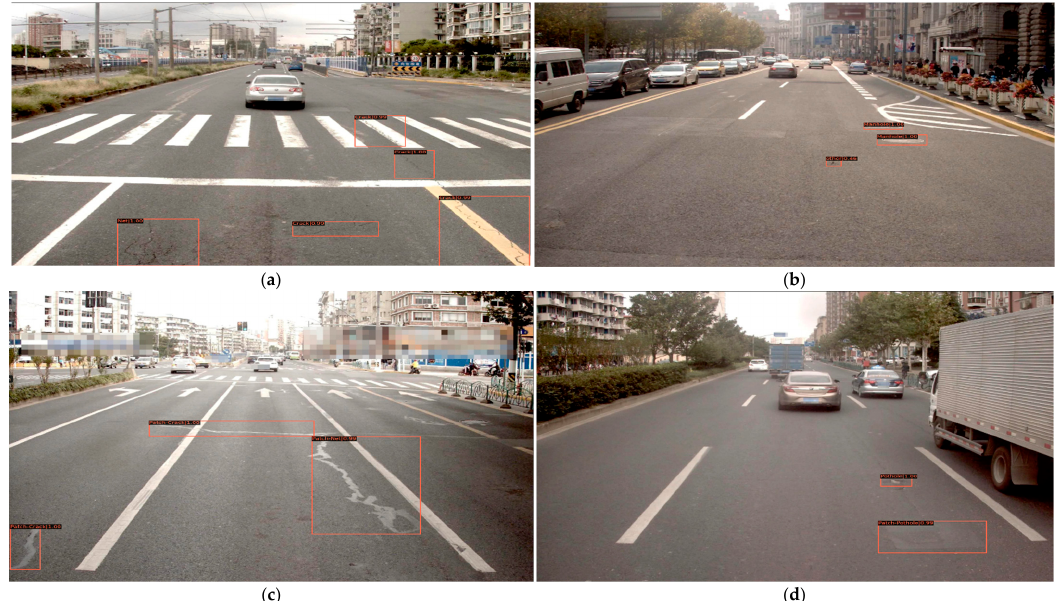
Figure 9. Disease detection samples for DASNet. ( a ) Net, Crack. ( b ) Other, Manhole. ( c ) Pothole, Patch-Pothole. ( d ) Patch-Crack, Patch-Net.